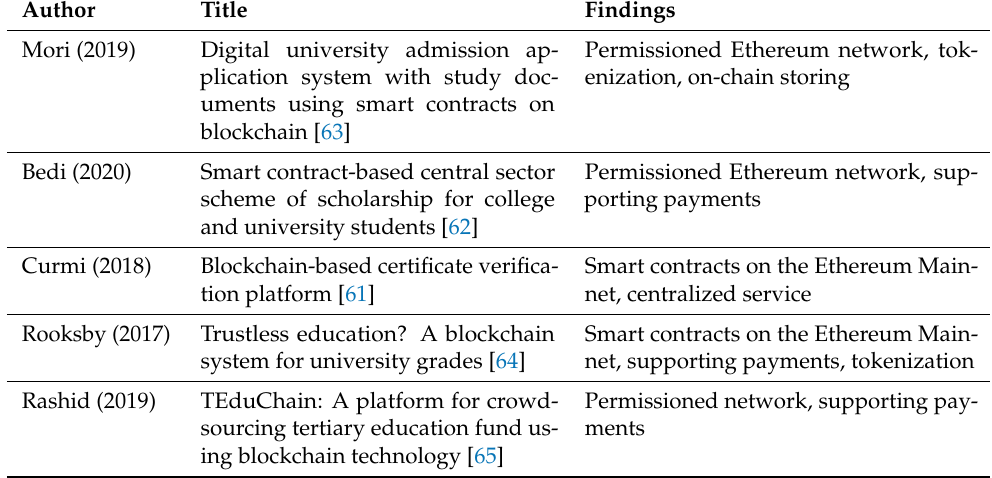
Table 5. Admissions and payments summary